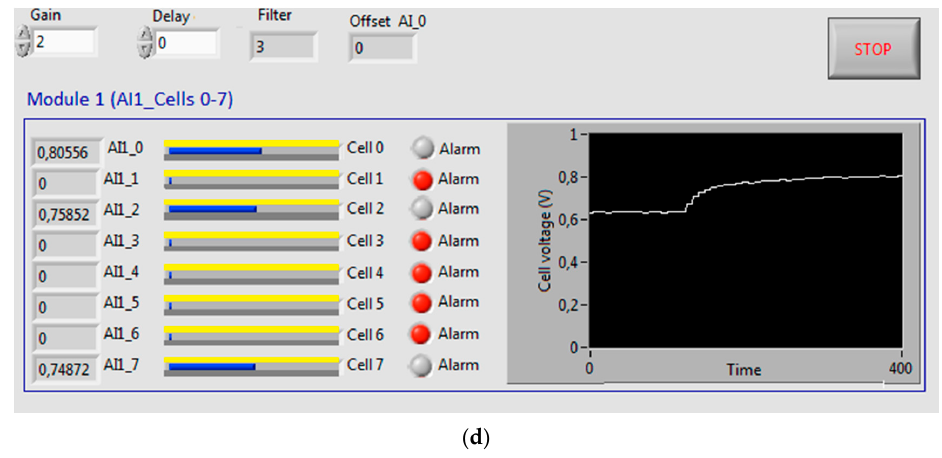
Figure 14. GUI under different operation regimes: ( a ) load connection; ( b ) Increase of load demand; ( c ) Reduction of load demand; ( d ) Alarm situation due to hydrogen scarcity.